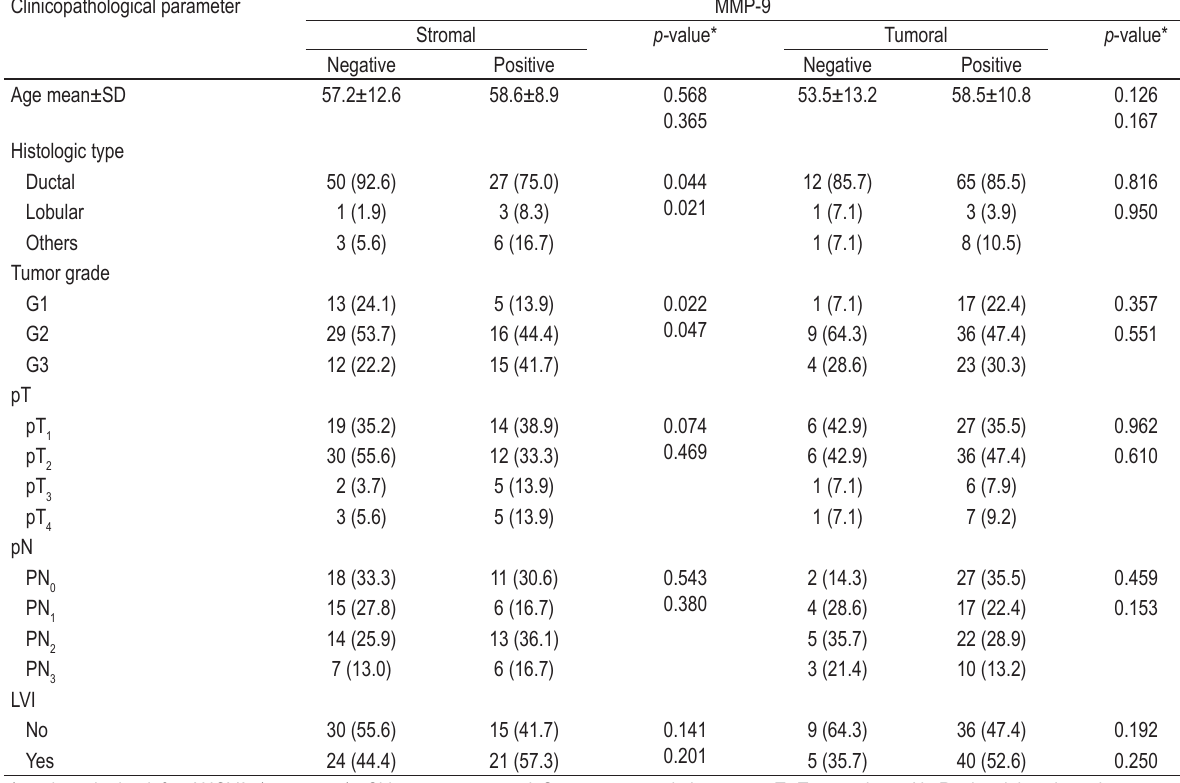
TABLE 3. Correlation of MMP-9 expression and standard clinicopathological parameters of breast cancer Clinicopathological